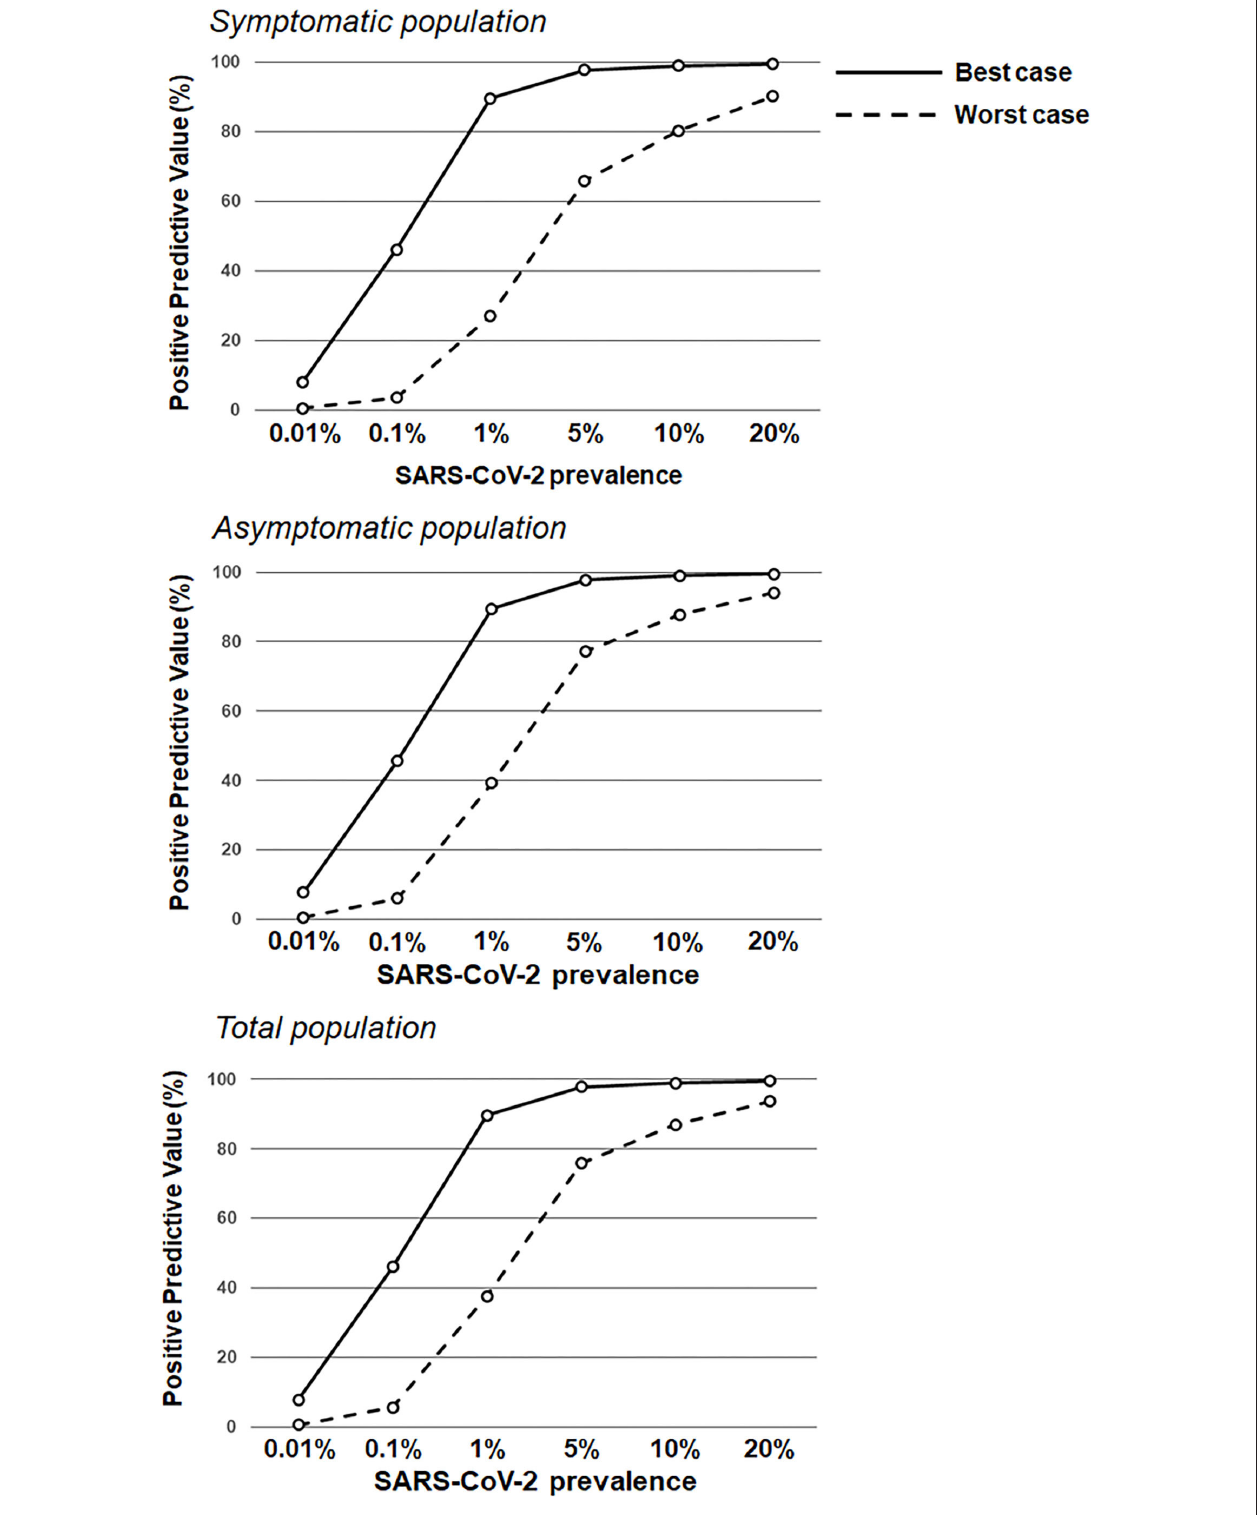
FIGURE 1 | Positive predictive values based on RAT sensitivity/specificity over a range of theoretical SARS-CoV-2 prevalence values. RAT positive predictive value estimates in the symptomatic population ( top ; sensitivity of 77.2 and 85.6% in the worst antigen diagnostic performance estimates and best antigen diagnostic performance estimates, respectively; and specificity of 97.9 and 99.9% in the worst antigen diagnostic performance estimates and best antigen diagnostic